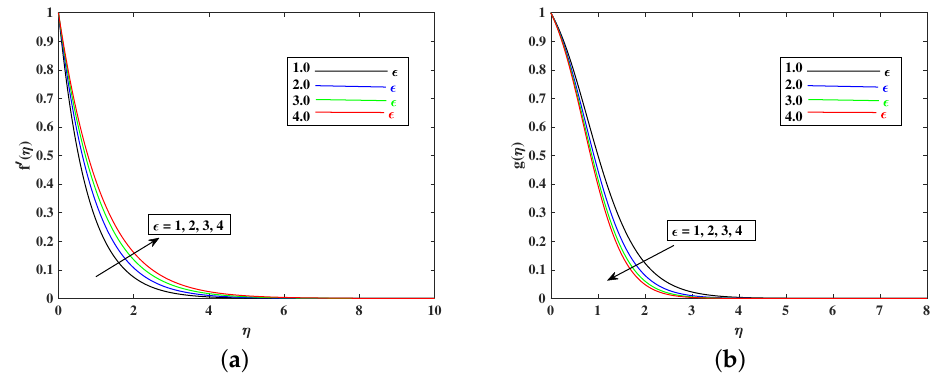
Figure 7. Variation of (cid:101) to influence the velocity and temperature profile. ( a ) Variation of (cid:101) to influence the velocity. ( b ) Variation of (cid:101) to influence the temperature.